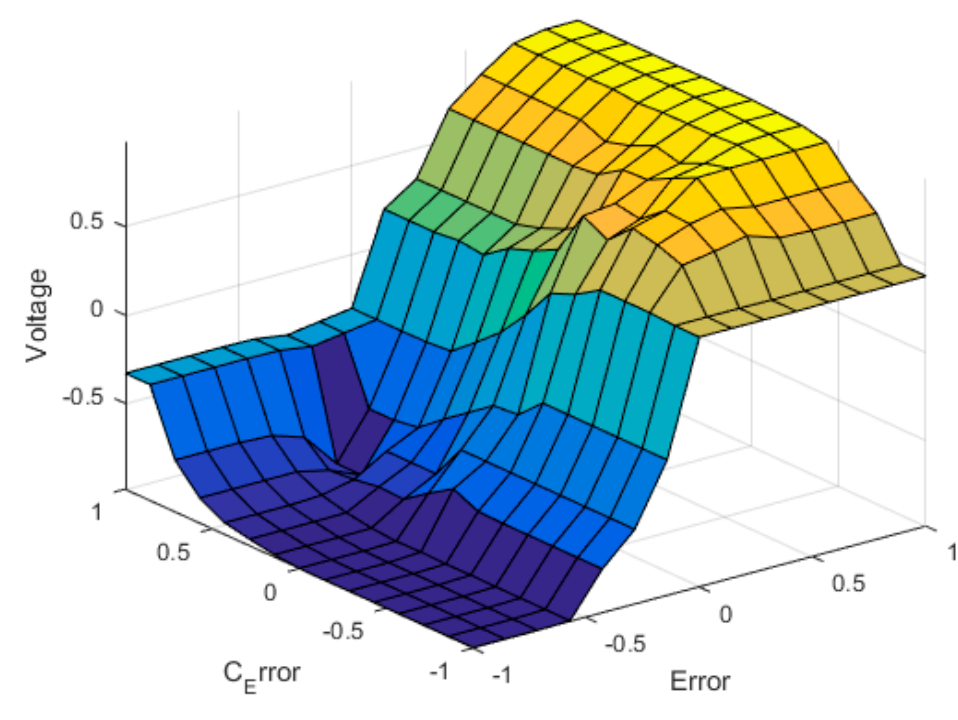
Figure 5. DC motor surface controller. Figure 6. TI-T2 with uncertain parameter a .